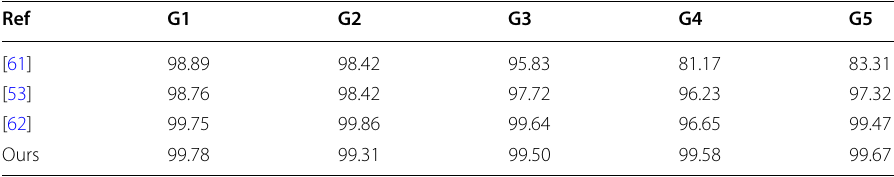
Table 4 Detection accuracy on the PKU